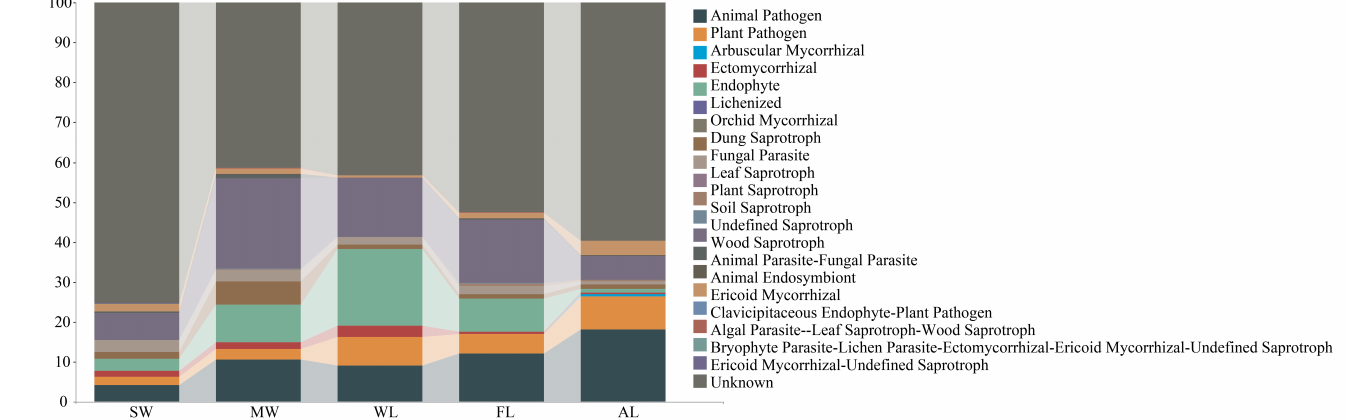
Figure 6. Relative abundance of bacterial metabolic pathways predicted by PICRUSt2. SW, swamp wetland; MW, meadow wetland; WL, woodland; FL, farmland; AL, alkaline land.